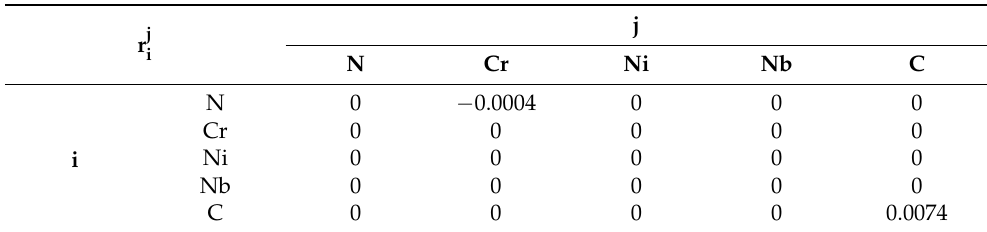
Table 3. Second-order interaction parameter r j Data from [13].